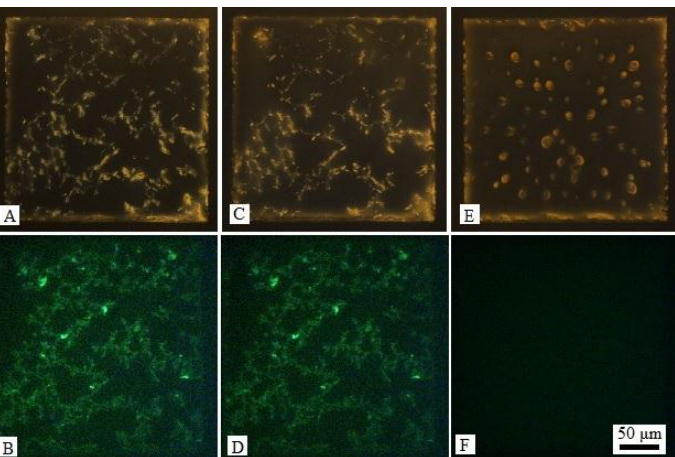
Figure 4. ( A ) Optical images (crossed polars) and ( B ) corresponding fluorescence micrographs of LC-aqueous interface decorated with DNA-lipids and L -DLPC, and dyed by SYBR Green; ( C ) Optical images and ( D ) corresponding fluorescence micrographs after the introduction of 20 μM random DNA strands for 10 min in ( A ); ( E ) Optical images and ( F ) corresponding fluorescence micrographs after the introduction of 20 μM c-DNA of DNA-lipids for 3 min in ( C ).